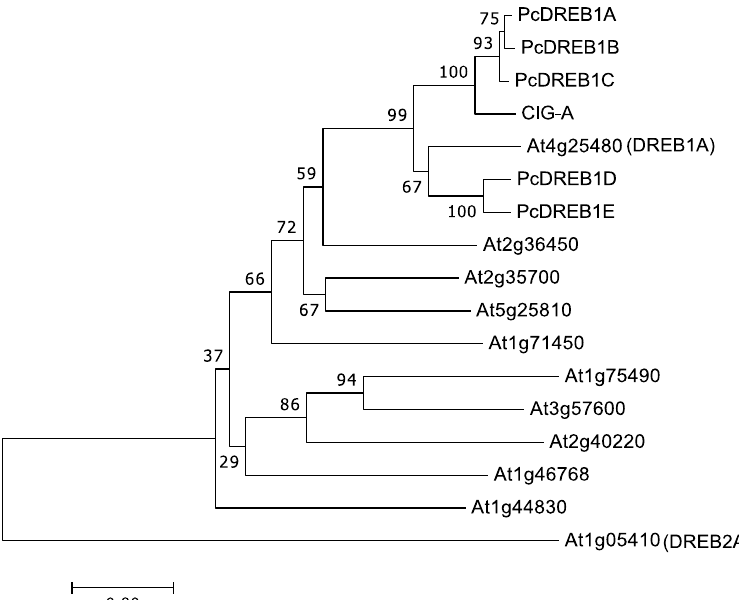
Figure 4. Phylogenetic tree based on the amino acid sequences of PcDREBs and dehydration-responsive element-binding protein / C-repeat binding factor (DREB) proteins from Arabidopsis : the tree was constructed using the neighbor-joining method, with MEGA version 7.0. Branch numbers refer to the percentage of replicates that support the branch using the bootstrap method (1000 replicates). The scale bar corresponds to 0.2 amino acid substitutions per residue. The sequences of Arabidopsis DREB proteins were obtained from Mizoi et al. [15]. CIG-A accession number: Q8H9A2. Gene names of PcDREBs in the Genome Database for Rosaceae are PCP009299.1 (PcDREB1A), PCP014363.1 (PcDREB1B), PCP011972.1 (PcDREB1C), PCP019717.1 (PcDREB1D), and PCP012284.1 (PcDREB1E).